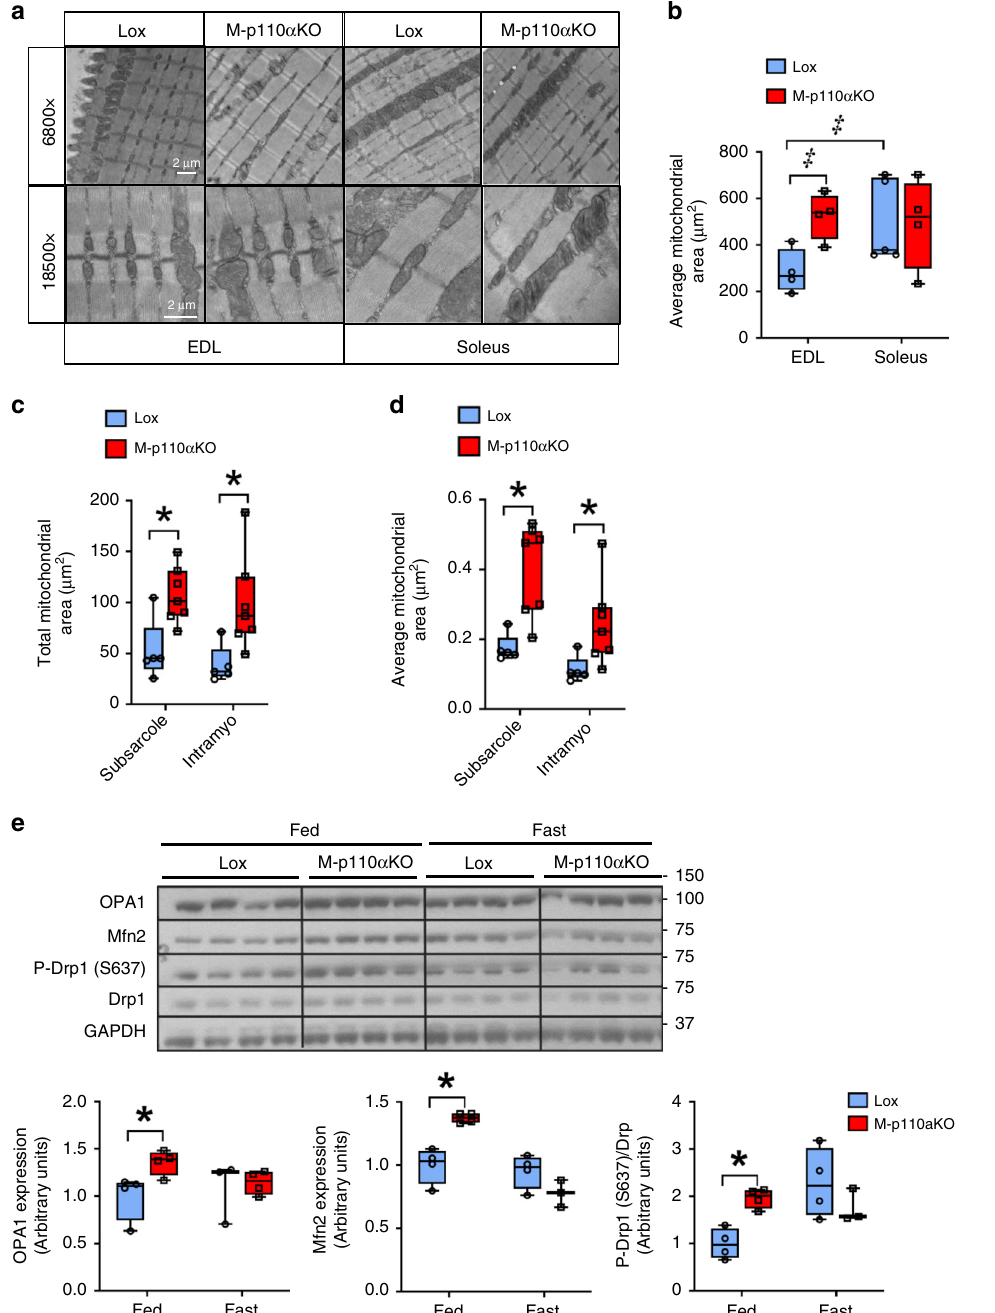
Fig. 3 Larger mitochondria associated with altered mitochondrial dynamics. a Ultrastructure of the mitochondria in transverse planes of EDL and soleus muscles from M-p110 α KO and controls viewed by EM. b Quanti fi cation of the average mitochondrial size from EDL and soleus muscles in panel a ( n = 4). c , d Quanti fi cation of the total mitochondria area per muscle fi ber view – sight ( c ) and the average mitochondrial area ( d ) from M-p110 α KO and controls transfected with Mito-GFP in panel c (ctrl, n = 3; KO, n = 4 with four to ten fi bers per mouse). e Western blot and densitometric analysis of proteins involved in mitochondrial dynamics in TA muscles of M-p110 α KO and controls fasted for 24 h or randomly fed. All mice were 4- to 5-month old. * P < 0.05 by Student ’ s t test; ‡ P < 0.05 by two-way ANOVA. Electron microscopy EM, subsarcole subsarcolemma, intramyo intramyo fi brillar. Box plots visualize the fi ve-number summary of the data set (minimum, lower quartile, median, upper quartile, and